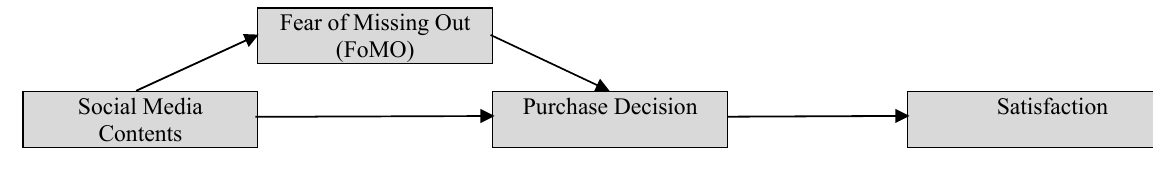
Fig. 2. The Research